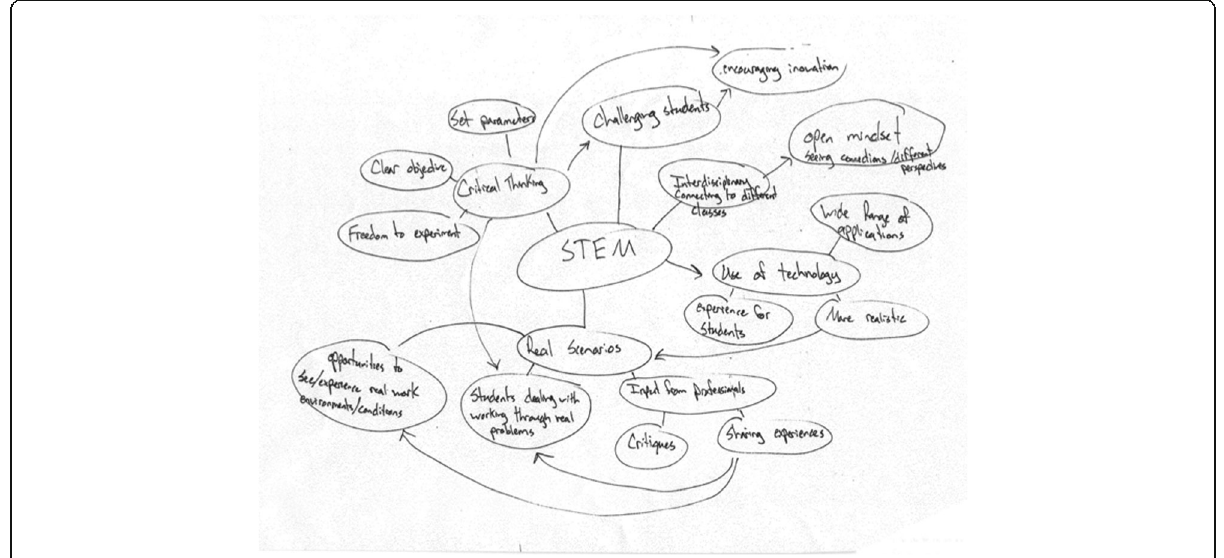
Fig. 2 Hierarchically arranged concept map from Hunter,